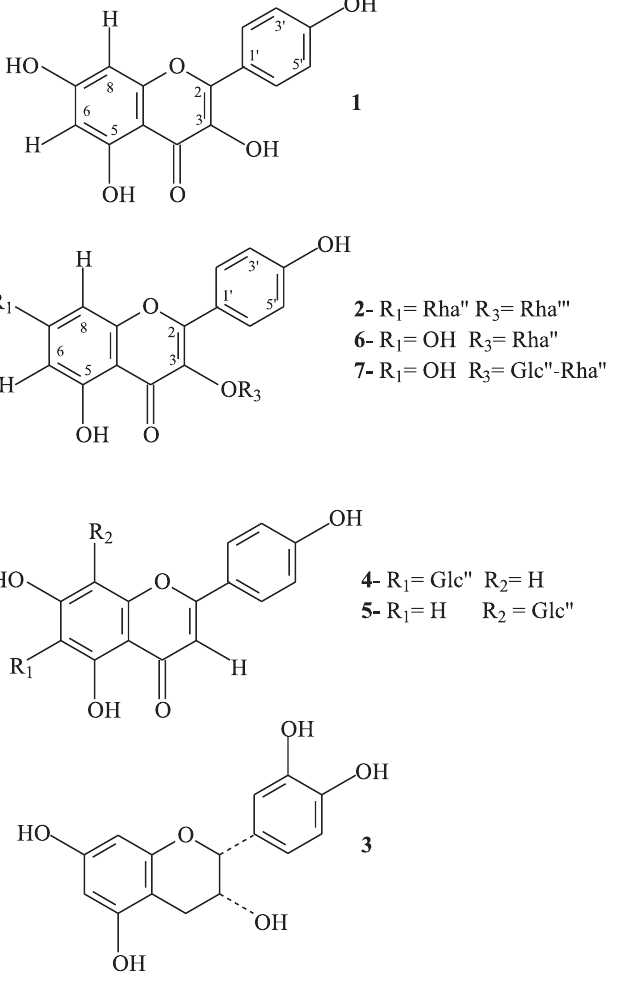
FIGURE 1 - Substances isolated from leaves and roots of S.